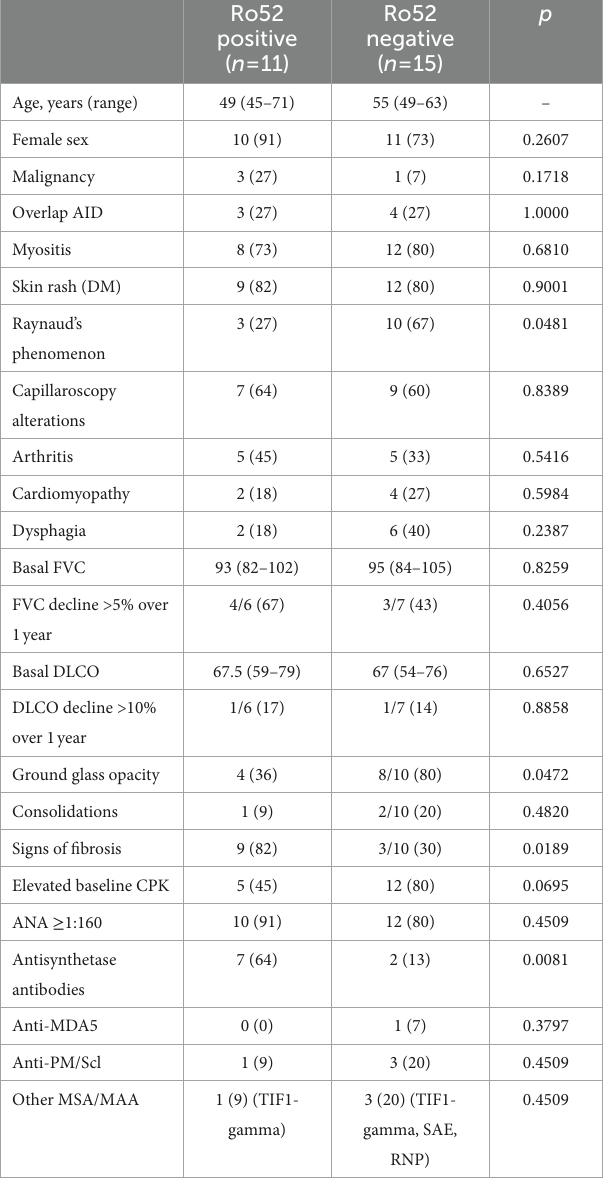
TABLE 2 Demographic, clinical, autoimmune features of the studied cohort of patients with inflammatory myositis and ILD, based on their anti-Ro52